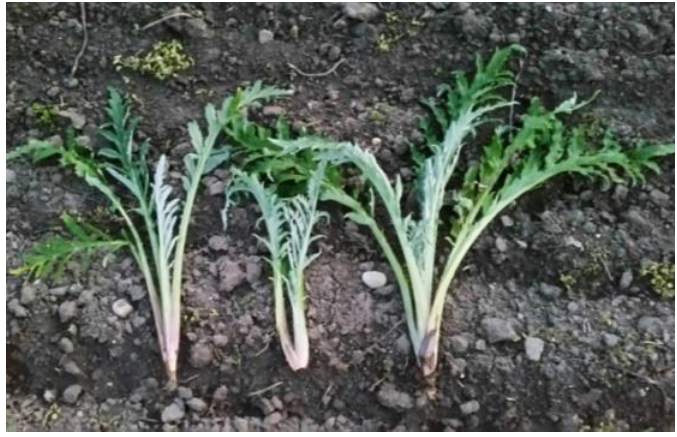
Figure 7. Offshoots (so-called cardoni or carducci ) of a globe artichoke